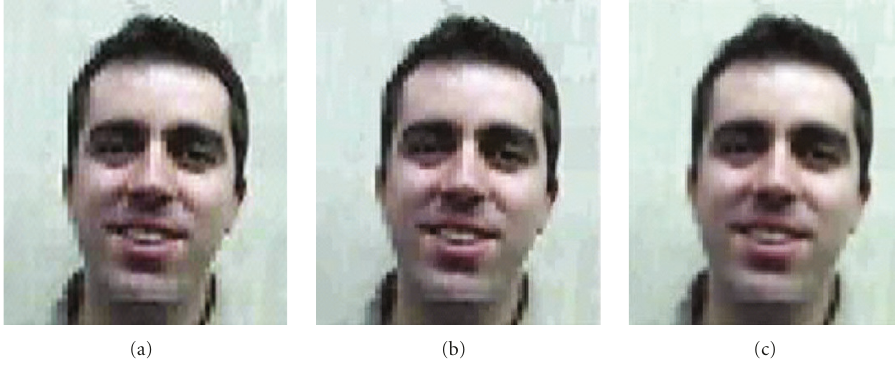
Figure 4: Left to right: (a) original scaled frame, (b) bicubic interpolation, (c) our